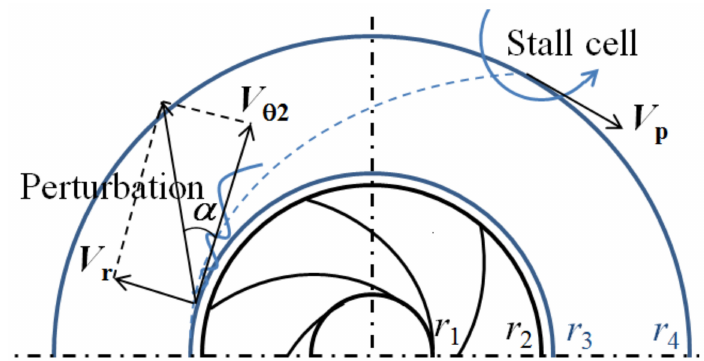
Figure 5. Illustration of the inlet perturbation and stall cell in the vaneless di ff user ( V r : radial velocity; V θ 2 : tangential velocity; r 1 and r 2 : impeller inlet and outlet radii; r 3 and r 4 : di ff user inlet and outlet